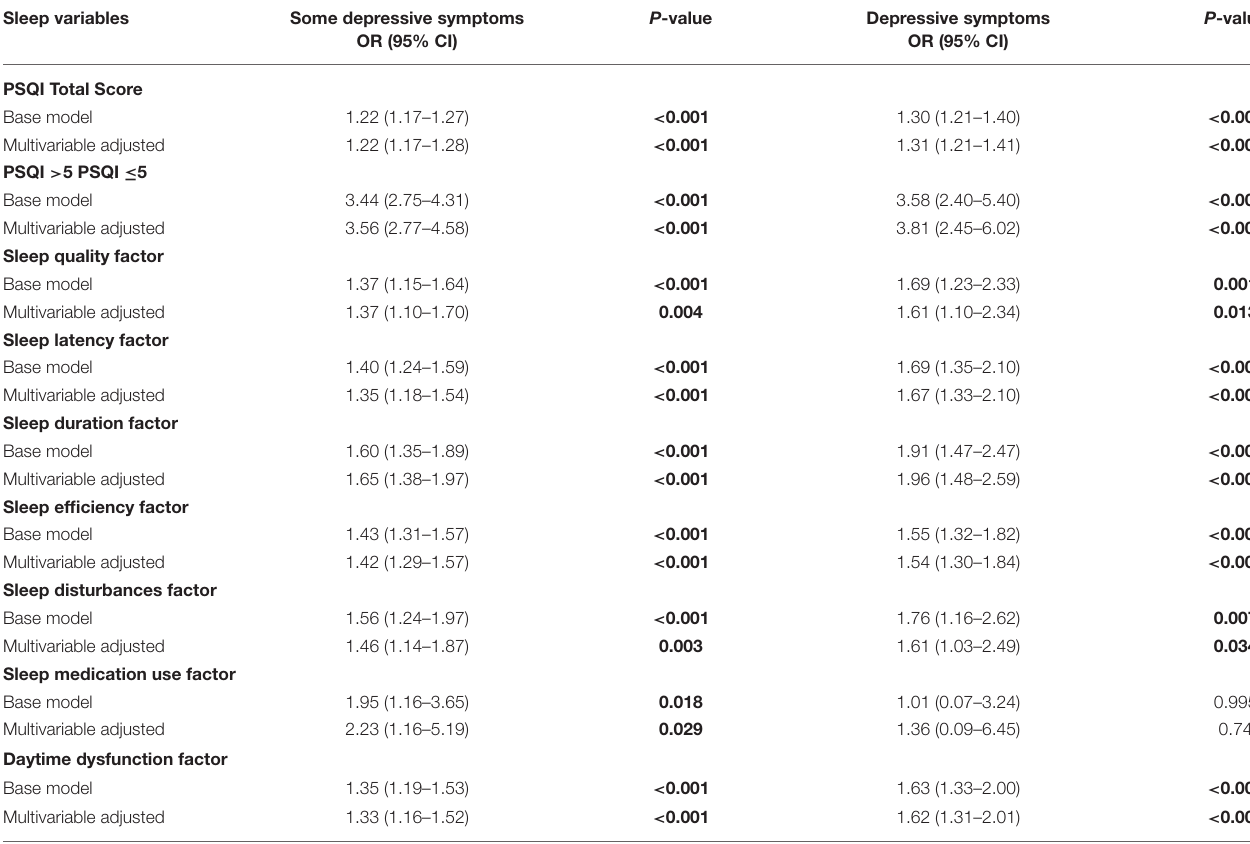
TABLE 2 | Associations between sleep disturbance and depressive symptom levels at